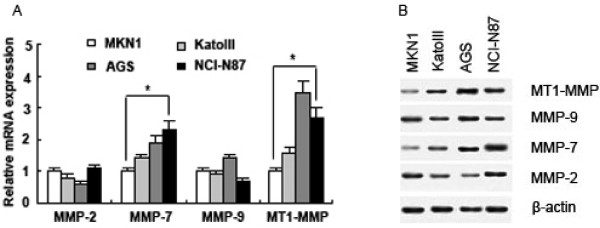
The expression of MMP-2, MMP-7, MMP-9 and MT1-MMP in gastric cancer cell lines MKN1, KatoIII, AGS and NCI-N87. (A) Differential mRNA expression of MMP-2, MMP-7, MMP-9 and MT1-MMP in MKN1, KatoIII, AGS and NCI-N87 was found by real-time PCR. Data are expressed as mean ± SD, n = 3, *P < 0.05. (B) Differential protein expression of MMP-2, MMP-7, MMP-9 and MT1-MMP in MKN1, KatoIII, AGS and NCI-N87 was found by Western blotting.